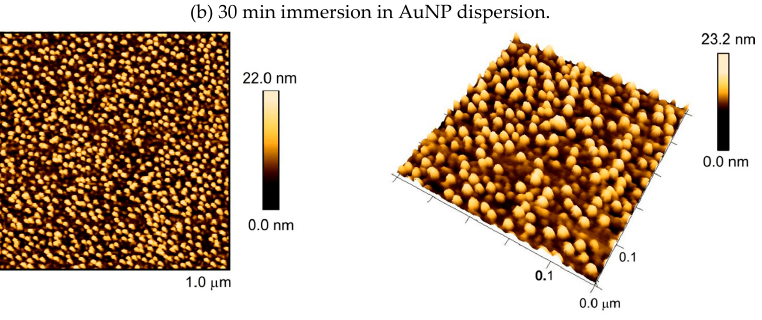
Figure 6. Reversible morphology switch of 5 nm AuNP – star-RAFT-polymer hybrid surface ( M n = 84 kg/mol and Σ = 2.9). On the left side, the AFM image shows the AuNP functionalized surface after incubation in toluene; no periodically-structured surface can be observed. After dewetting with water/DMF, a globular structure with ca. 21 nm domain size was formed (right). The switching of the morphology is reversible. Figure 6 shows the transition between the two morphologies of the AuNP – star-RAFT-polymer hybrid surface. The grafted polystyrene had a molar mass of M n = 84 kg/mol and was grafted with Σ = 2.9. The left AFM image shows the surface of the substrate after wetting in toluene. The height difference and root mean square roughness R q were determined to be 6 nm and 0.85 nm, respectively. For comparison, a homogeneous polymer layer typically has a height difference of approximately 2.5 nm and R q = 0.3 nm, as, e.g., seen in Figure 3a. Both surface parameters increased here with the embedded nanoparticles, but no periodically-nanostructured surface was obtained. The AuNPs were apparently well buried in the expanded surface-bound polymer layer and could not be seen directly. This AuNP – star-RAFT-polymer hybrid surface was then immersed in dimethylformamide, and subsequently dewetted with water. Figure 6 (right) shows a periodic globular nanostructure of polystyrene and AuNPs. The height difference and root mean square roughness increased significantly to 10.7 nm and 1.71 nm, respectively, reflecting the more pronounced structure.